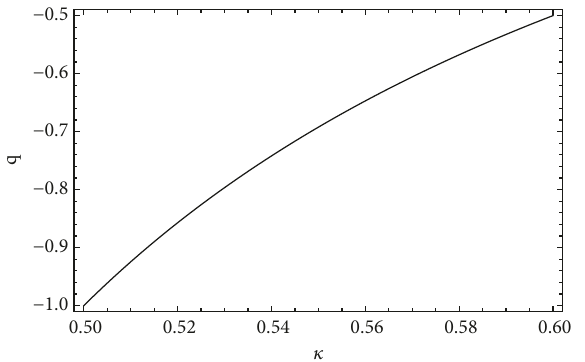
Figure 2: Case II: 𝑞 as a function of 𝜅 .